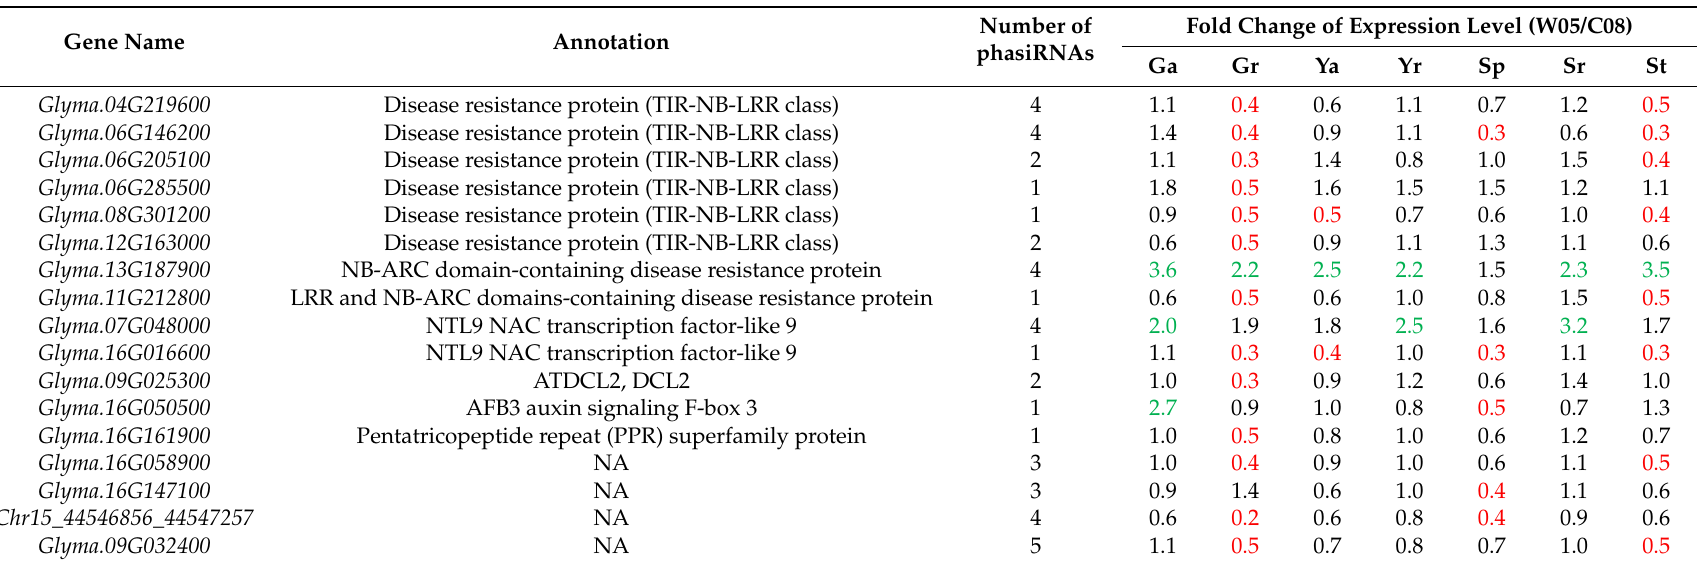
Table 2. Changes in the abundances of phasiRNAs in W05 (wild) and C08 (cultivated)